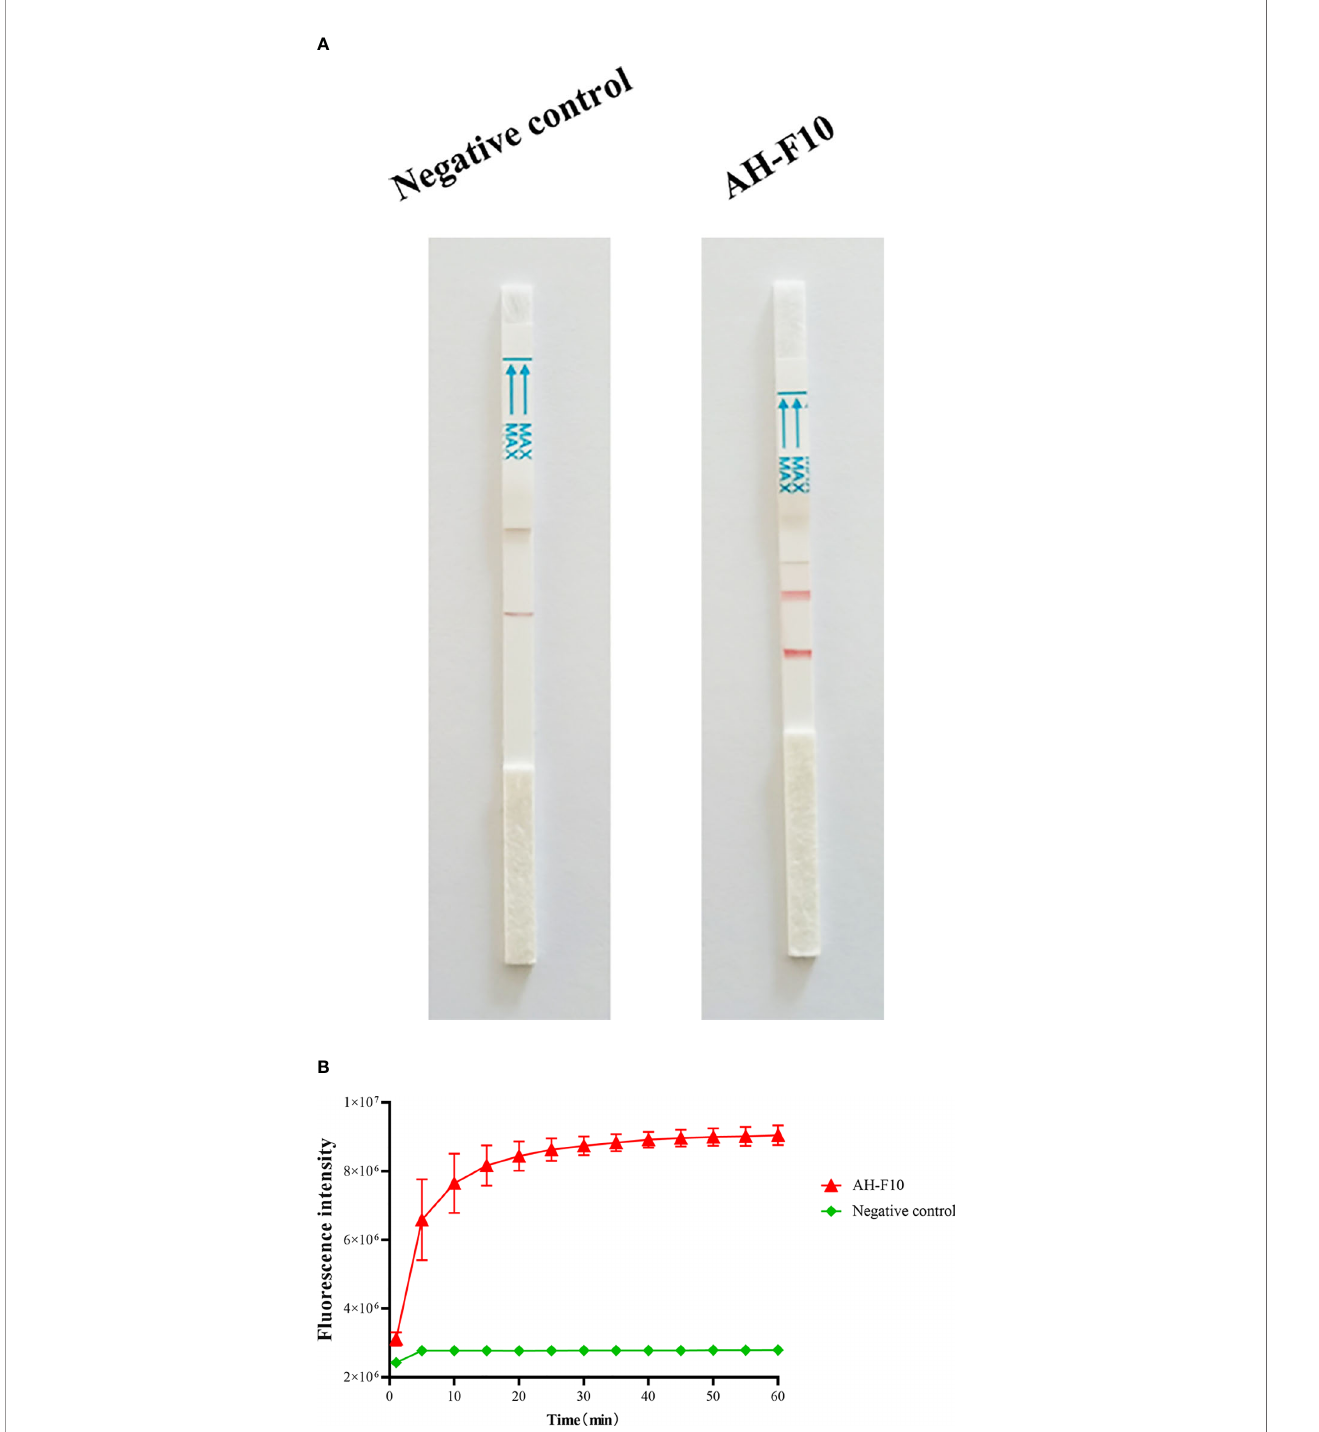
FIGURE 2 | Performance of DTMUV Cas13a lateral fl ow and fl uorescence detection. (A) Analysis of DTMUV by Cas13a lateral fl ow detection. (B) Analysis of DTMUV by Cas13a fl uorescence detection. n = 3 technical replicates; values represent mean ±